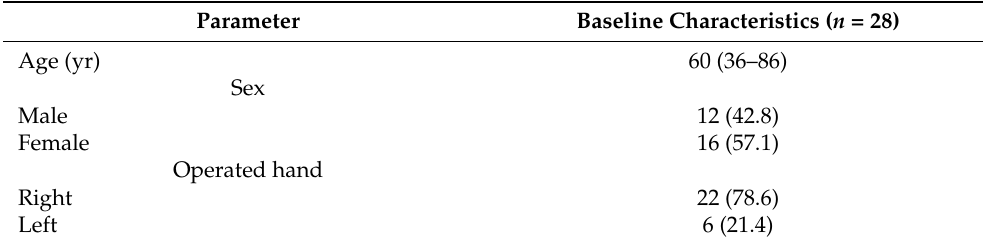
Table 3. Patients’ characteristics for revision surgery.